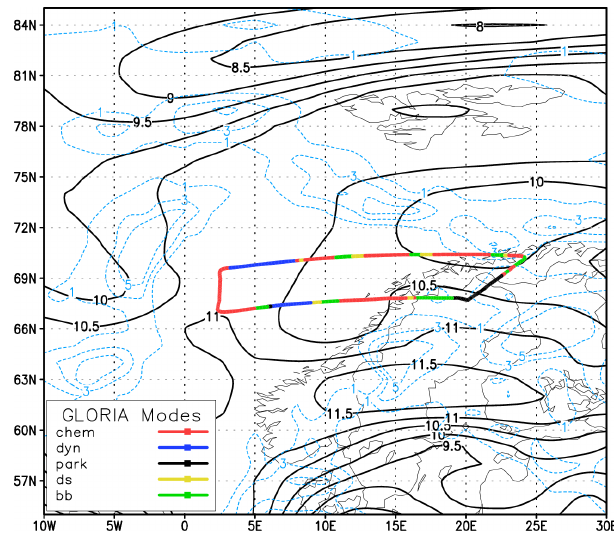
Figure 1. Potential vorticity (in PVU, black solid lines) on a 370K isentropic surface (at approximately flight level) and cirrus clouds at lower levels (shown by cloud ice water content [10 5 kgkg − 1 ] on 280K, blue lines) and the track of the Geophysica aircraft for ESSenCe flight 2 of 16 December 2011. The abbreviations “dyn” and “chem” mark dynamics- and chemistry-mode measurements of GLORIA, respectively; “park” indicates that GLORIA is in parking position; “ds” and “bb” indicate deep space and blackbody calibra- tion measurements,